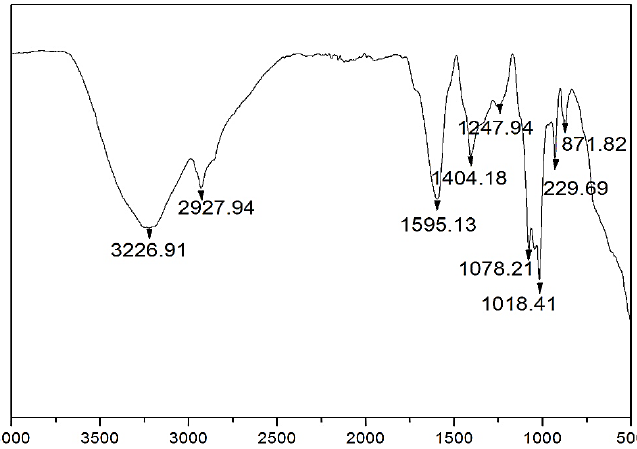
Figure 4. Fourier transform infrared (FT-IR) spectrum analysis of B. bassiana -28 extract, scanning it in the range 500–4000 cm −1 at a resolution value of 4 cm −1 . Table 4. Beauveria bassiana -28 mycelial crude metabolites of FT-IR Spectrum study.